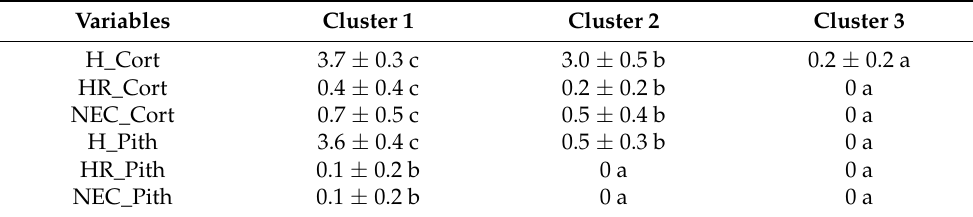
Table 3. Cluster analyses of sunflowers inoculated with different P. halstedii isolates based on the examined microscopic variables.